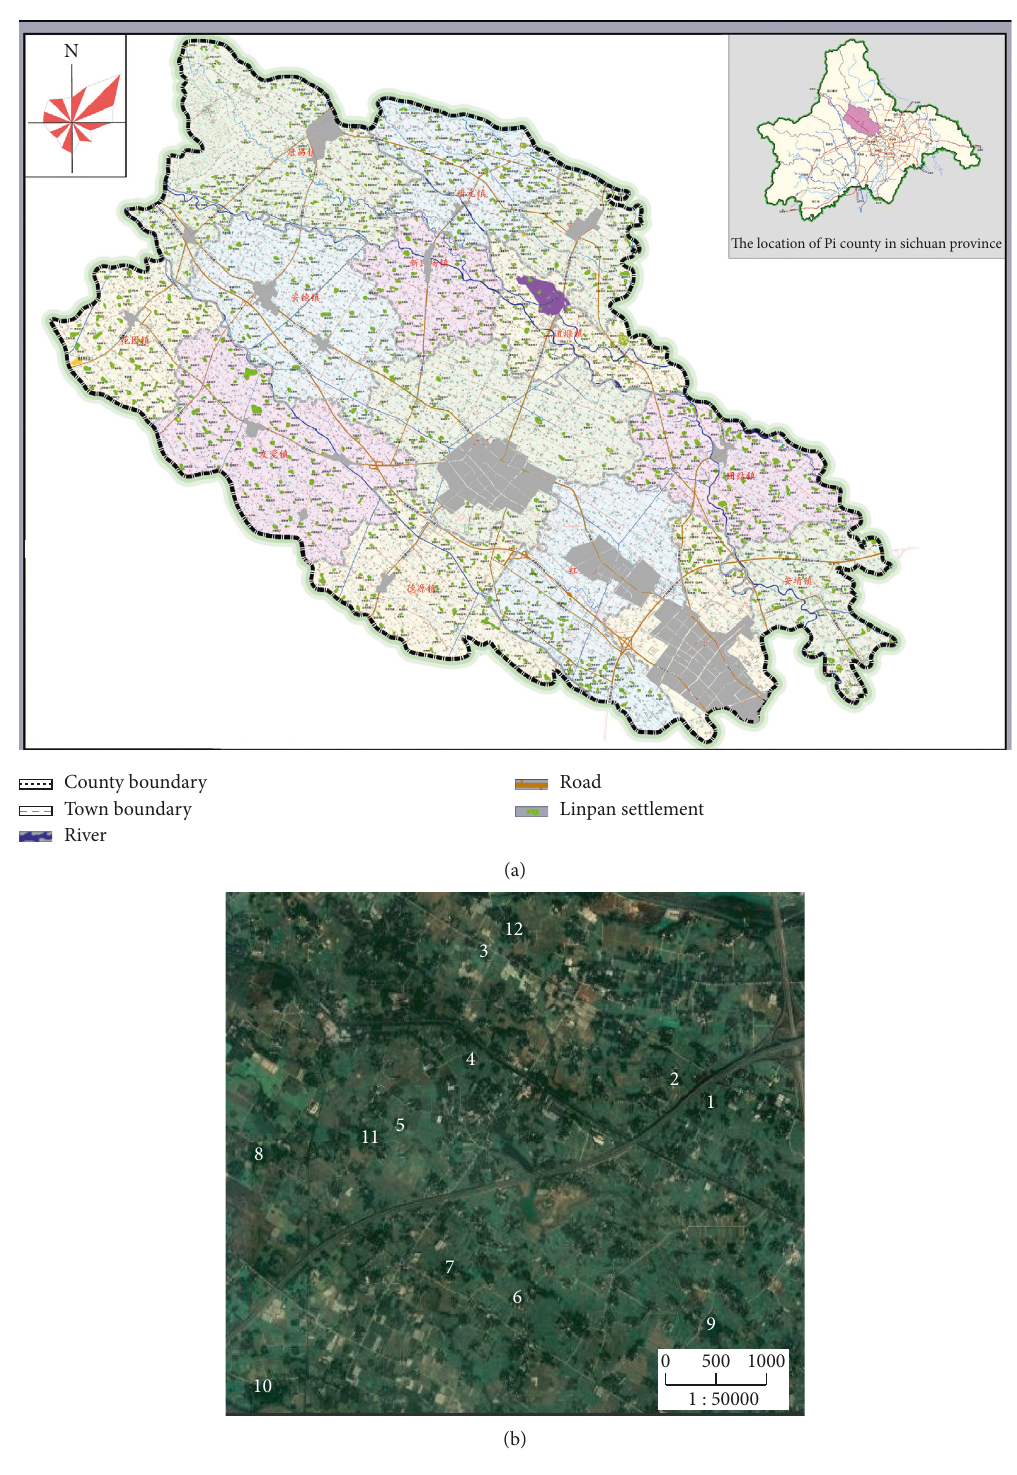
Figure 2: (a) The studied area in Sandaoyan town (purple area), Pi county, Chengdu Plain (base map from Pi County Planning and Construction Bureau); (b) the number of Linpan sample and its location (base map from Google